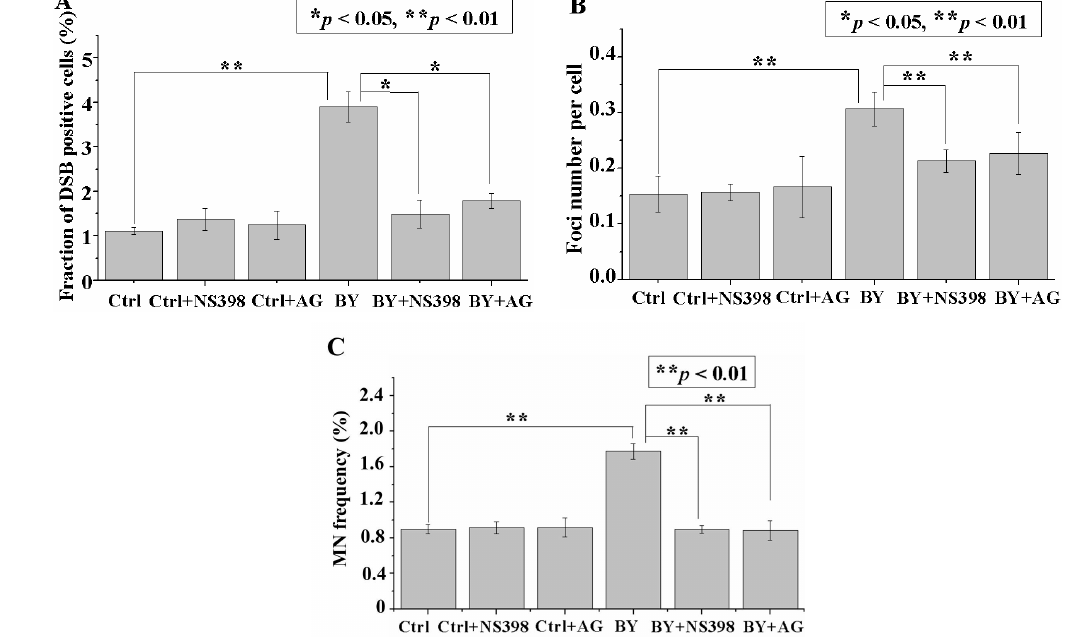
Figure 5. N -[2-(cyclohexyloxy)-4-nitrophenyl]-methanesulfonamide (NS 398) or aminoguanidine (AG) inhibits radiation-induced bystander effect (RIBE) induction. Fraction of p53BP1 positive cells ( A ); foci number per cell ( B ); and MN frequency ( C ) in the bystander cells with or without NS 398 (50 µM) or AG (1 mM) treatment. Data are pooled from at least three independent repeats and the results are presented as mean ± SD. Significances in the differences between the samples are determined and differences with p < 0.05 are considered statistically significant.